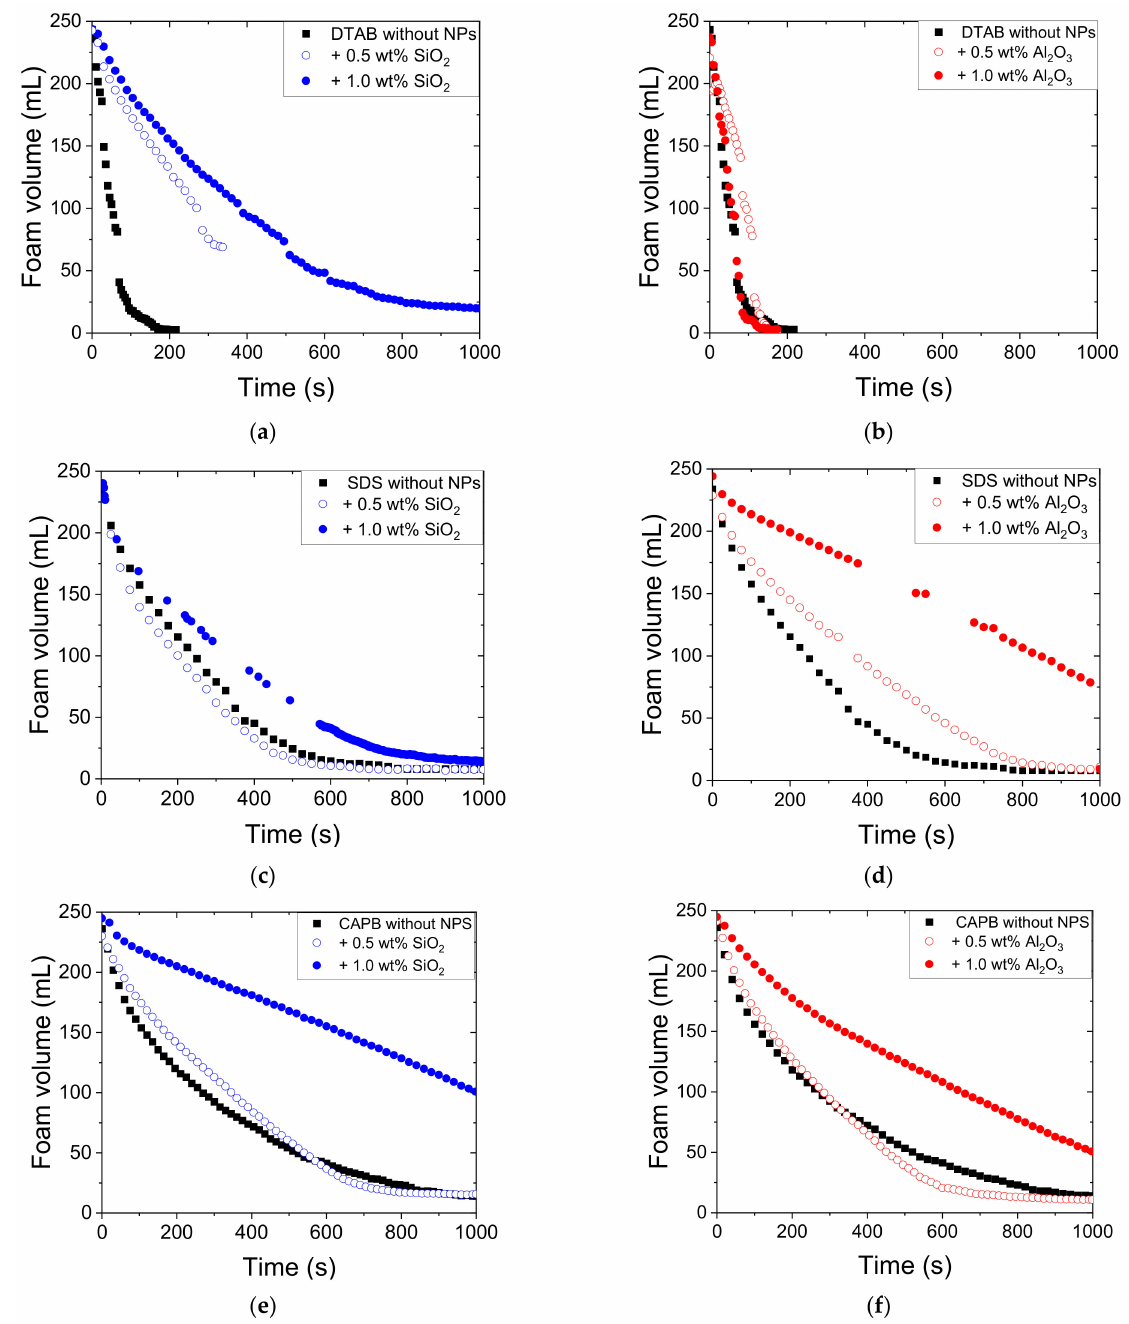
Figure 2. Foam decay profiles of CO 2 foam formed for 0.1 wt % ( a , b ) DTAB, ( c , d ) SDS, and ( e , f ) CAPB in the absence and presence of NPs (in brine at 25 ◦ C) (standard deviation: foam volume < 5